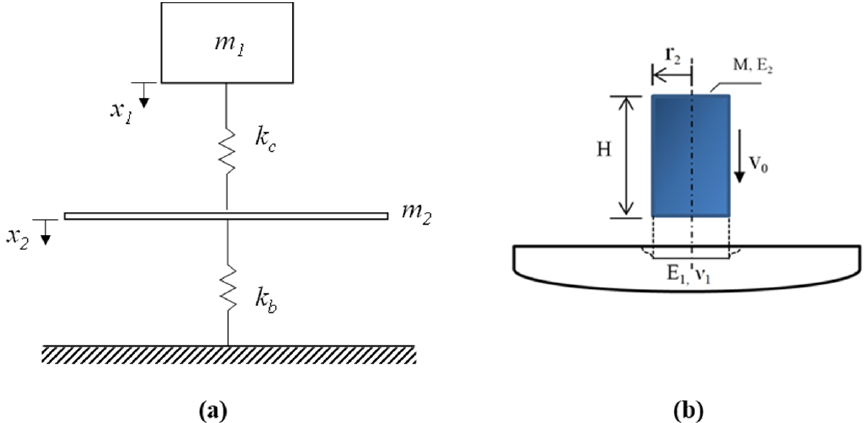
Figure 15. ( a ) Spring-mass model and ( b ) cylindrical striker impacting an elastic surface.